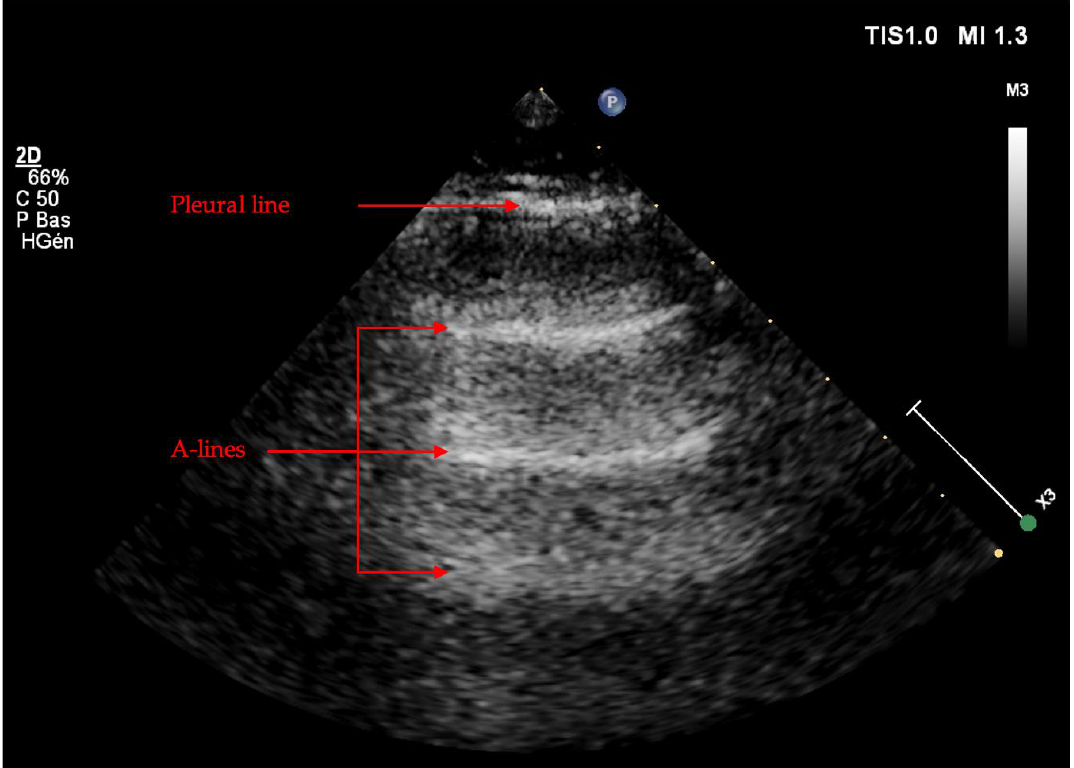
Figure 8. A-lines. A-lines represent horizontal parallel artefacts behind the pleural line at multiples of distance of the probe, indicating a good lung aeration (longitudinal view, linear probe).